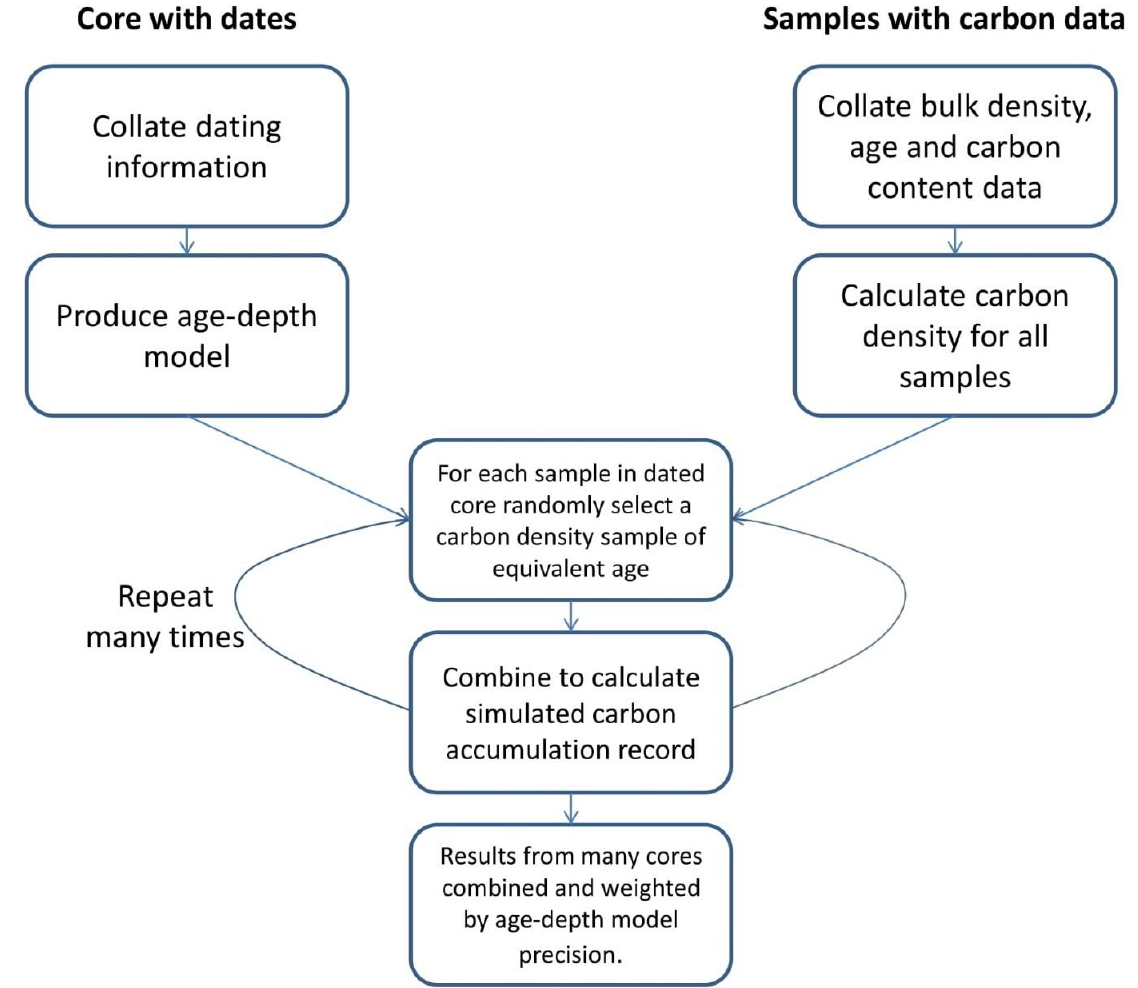
Figure A4. Schematic diagram of the process used to produce inferred records of carbon